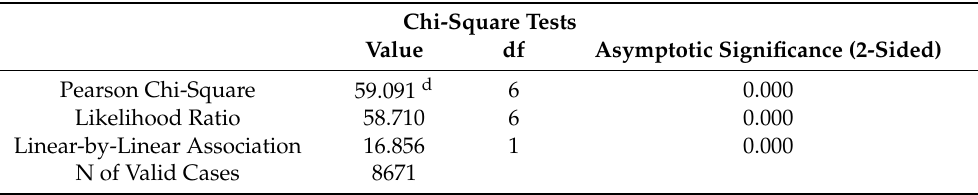
Table 13. Chi-square test (enterprise size vs. change in the ROE 2019 profitability indicator). Source: own research.